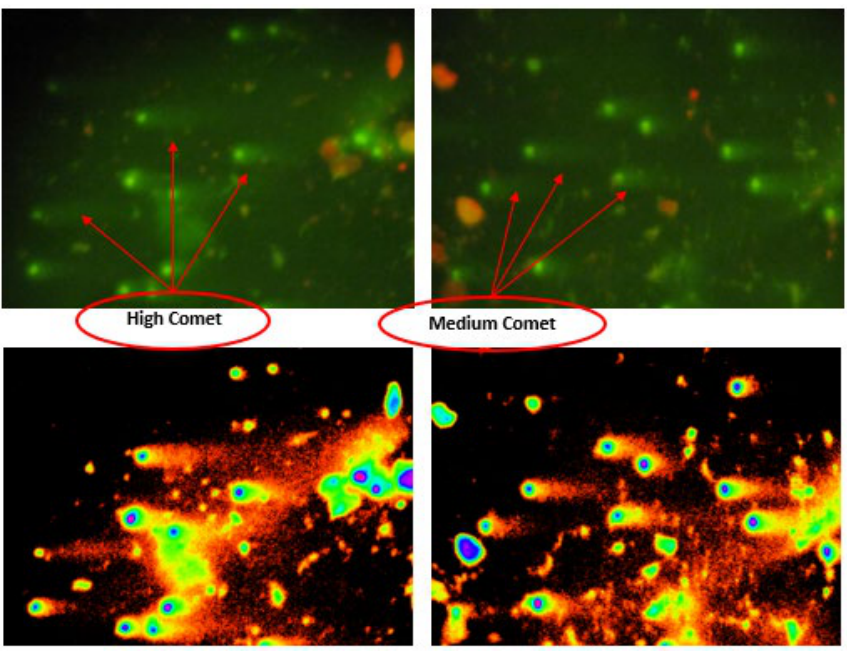
Figure 10. Positive control group (DM): high numbers of cells with high comet and medium comet by using comet score program.